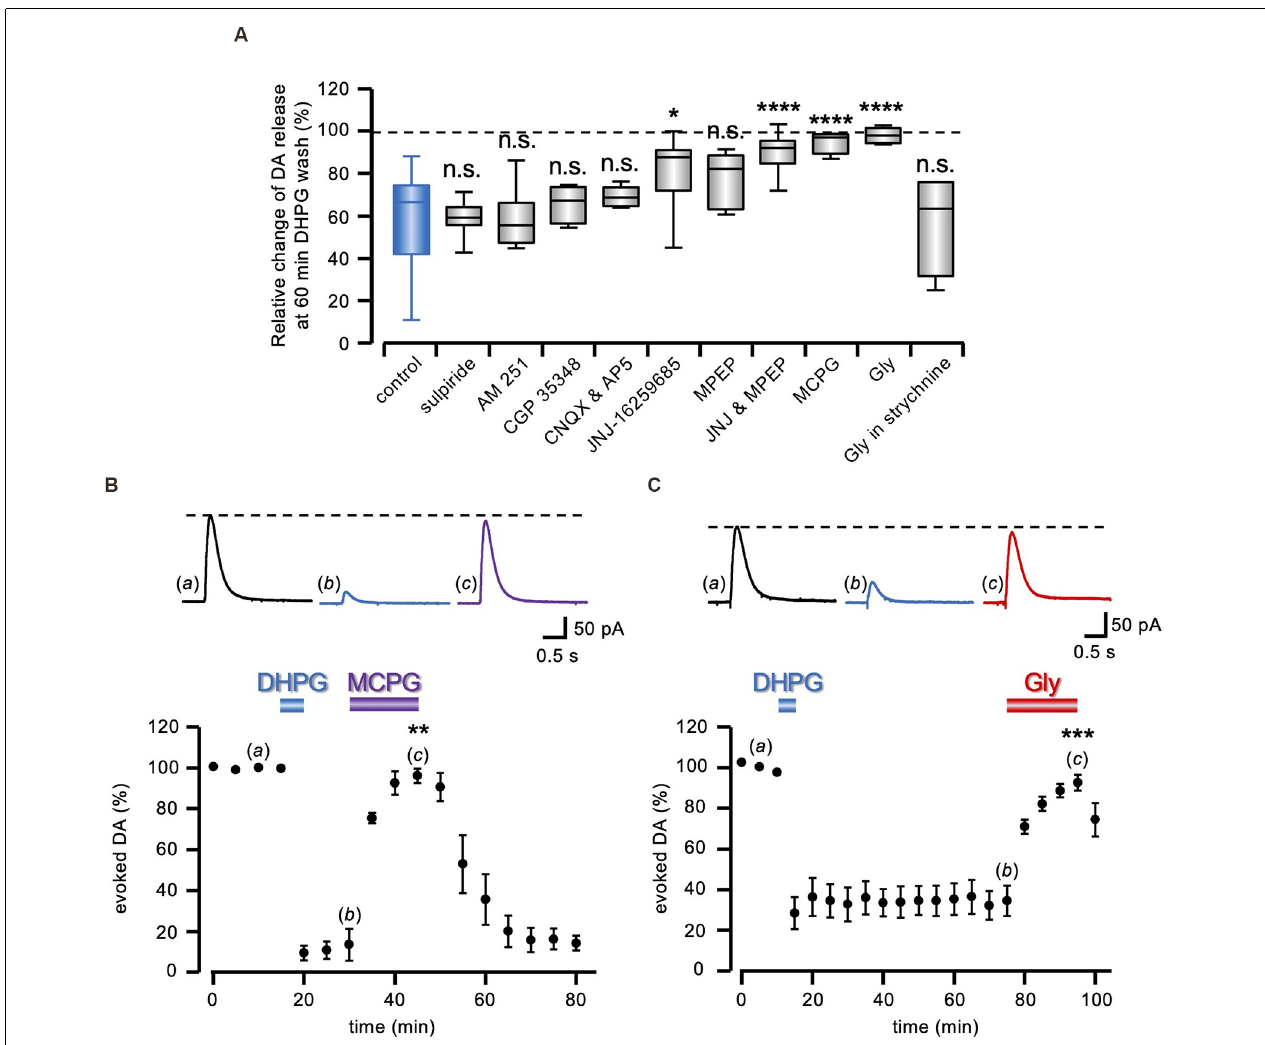
FIGURE 2 | Pharmacology of DA-LTD. (A) Box and whiskers plot of the change in evoked DA release, 60 min after DHPG (50 µ M) washout, relative to the DA signal preceding the DHPG treatment, in the presence of 1 µ M sulpiride ( n = 15 slices from six animals), 5 µ M AM 251 ( n = 7 slices from three animals), 200 µ M CGP 35348 ( n = 4 slices from two animals), 10 µ M CNQX ( n = 6 slices from three animals), 500 nM JNJ-16259685 ( n = 9 slices from four animals), 300 nM MPEP ( n = 9 slices from four animals), co-perfusion of JNJ and MPEP ( n = 11 slices from five animals), 1 mM MCPG ( n = 4 slices from two animals), 1 mM Gly ( n = 8 slices from four animals) and Gly in 1 µ M strychnine ( n = 4 slices from two animals). All statistical comparisons are made against the control condition (blue box), i.e., DHPG treatment with no additional drug illustrated in Figure 1 (n.s. P > 0.05, * P < 0.05, **** P < 0.0001, 1-way ANOVA followed by Bonferroni’s test). (B,C) Running plots of the mean relative amplitude ( ± s.e.m.) of evoked DA release, obtained with amperometric recordings at 5 min stimulation interval. On top, representative traces of the DA signal are shown at the time indicated by the letters in the plots. DA-LTD expression after DHPG (50 µ M) washout was reverted in (B) by 1 mM MCPG ( n = 4 slices from two animals) and in (C) by 1 mM Gly ( n = 5 slices from two animals). ** P < 0.01, *** P < 0.001, Student’s t-test for paired data, between evoked DA amplitude during and immediately before drug